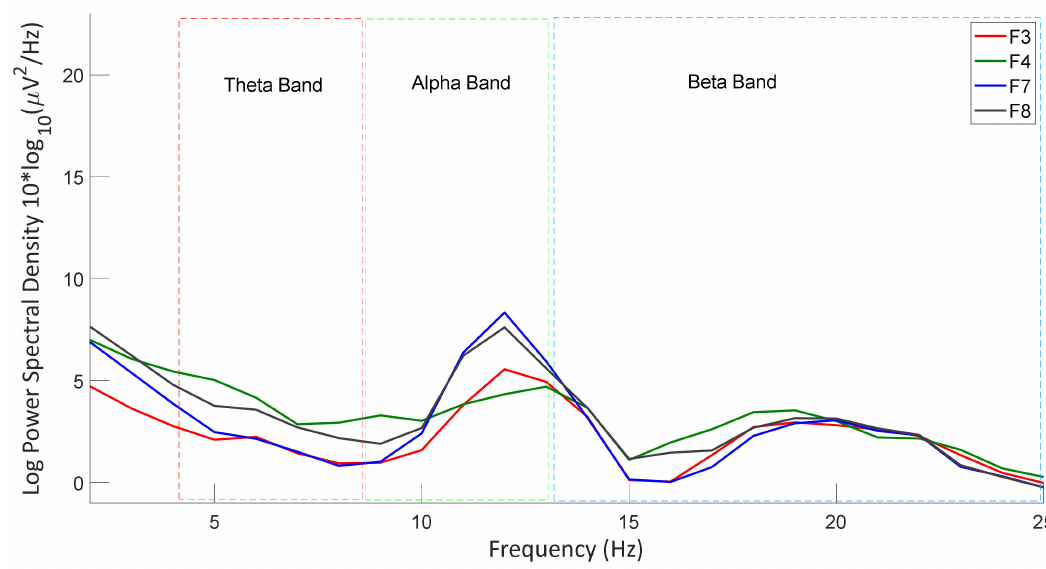
Figure 7. Power spectral density of each band for memory “no-recall” scenario.